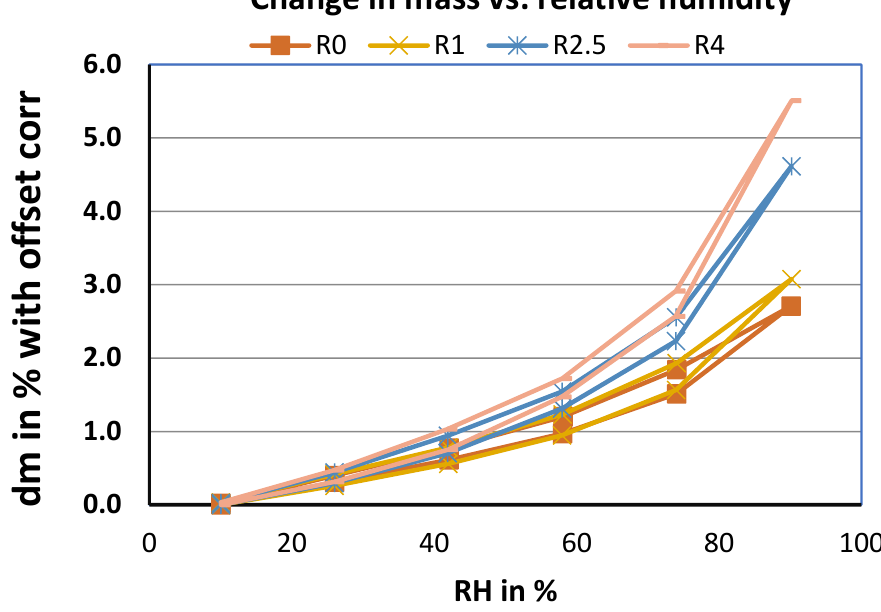
Figure 8. Moisture sorption isotherm of cob with different seaweed contents. This behavior comes from the hydrophilic nature of seaweed. For instance, at a RH value of 90%, the absorbed moisture in the cob reaches 2.5% of the sample mass. The water vapor permeability at 90% RH is equal to 17, 44, and 55% for R1, R2.5, and R4, respectively. Furthermore, by looking at the sorption and desorption curves, a hysteresis can be noticed. According to the IUPAC (International Union of Pure and Applied Chemistry),